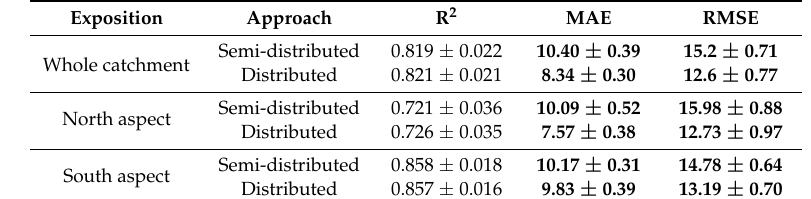
Table 3. R 2 , mean absolute error (MAE) and RMSE average and standard deviations values from the 100 sample bootstrapping for the observed and simulated SCA (based on the distributed and semi-distributed approaches) for the entire time period with SCA observation (2001–2015). Results for the entire study area and for North and South Expositions are presented. Error metrics in bold note p -values of the T -student test lower than 0.01 (99% confidence interval for rejecting null hypothesis).